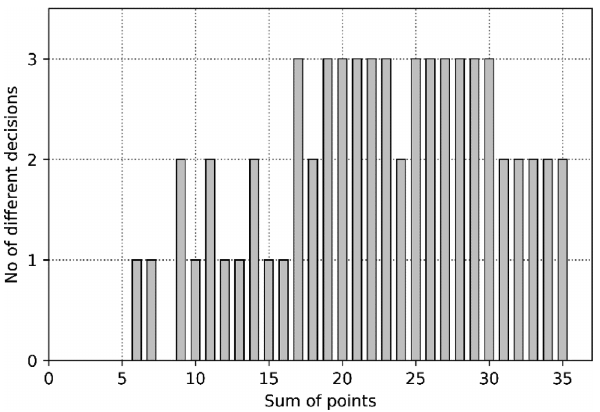
Fig. 2: Number of different decisions for a given number of total